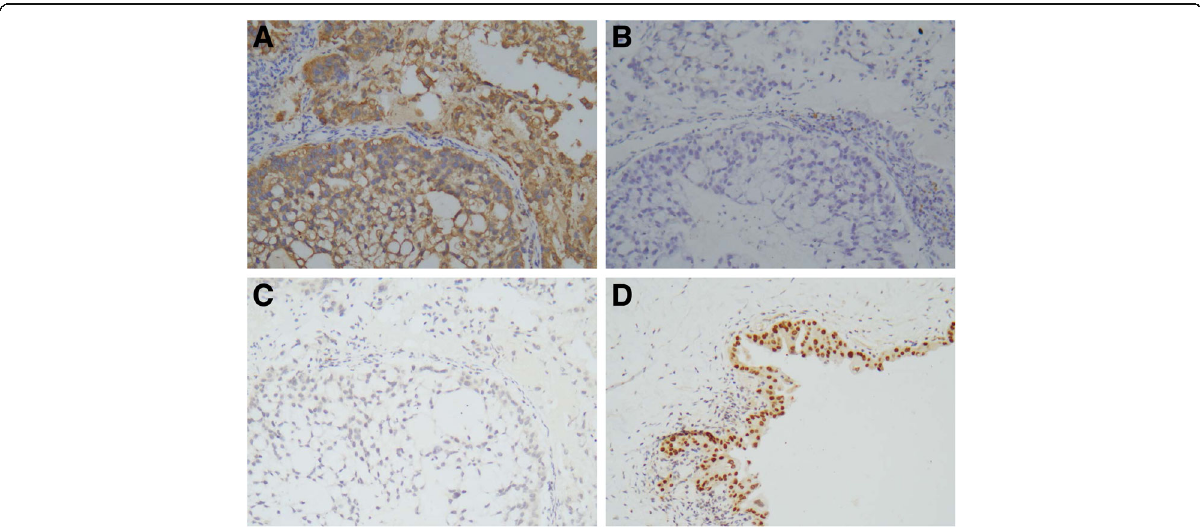
Fig. 2 Immunostaining of the poorly differentiated mucinous carcinoma with partial signet ring cell carcinoma of the ovary. The tumor cells are diffusely positive for CK7 [ a ], and negative for CK20 [ b ], PAX-8 [ c ]. The atypical endometriotic epithelium was positive for PAX-8 [ d ]. Original magnifications ×